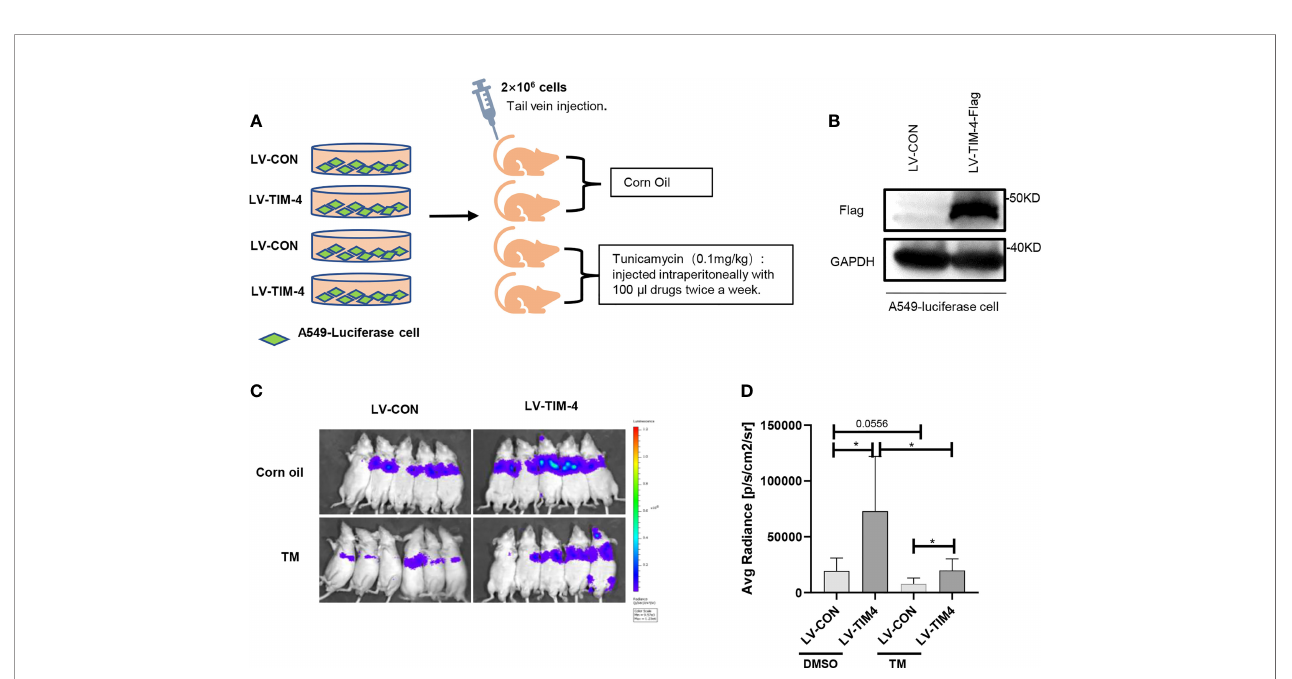
FIGURE 4 | N-glycosylated TIM-4 promotes metastasis of NSCLC cells in vivo . (A) Experimental fl ow chart and design. (B) Western Blot was used to detect the expression of TIM-4 protein. (C) Photographs of nude mice for in vivo imaging. (D) Statistics of nude mice for in vivo imaging. *p < 0.05, by Student ’ s